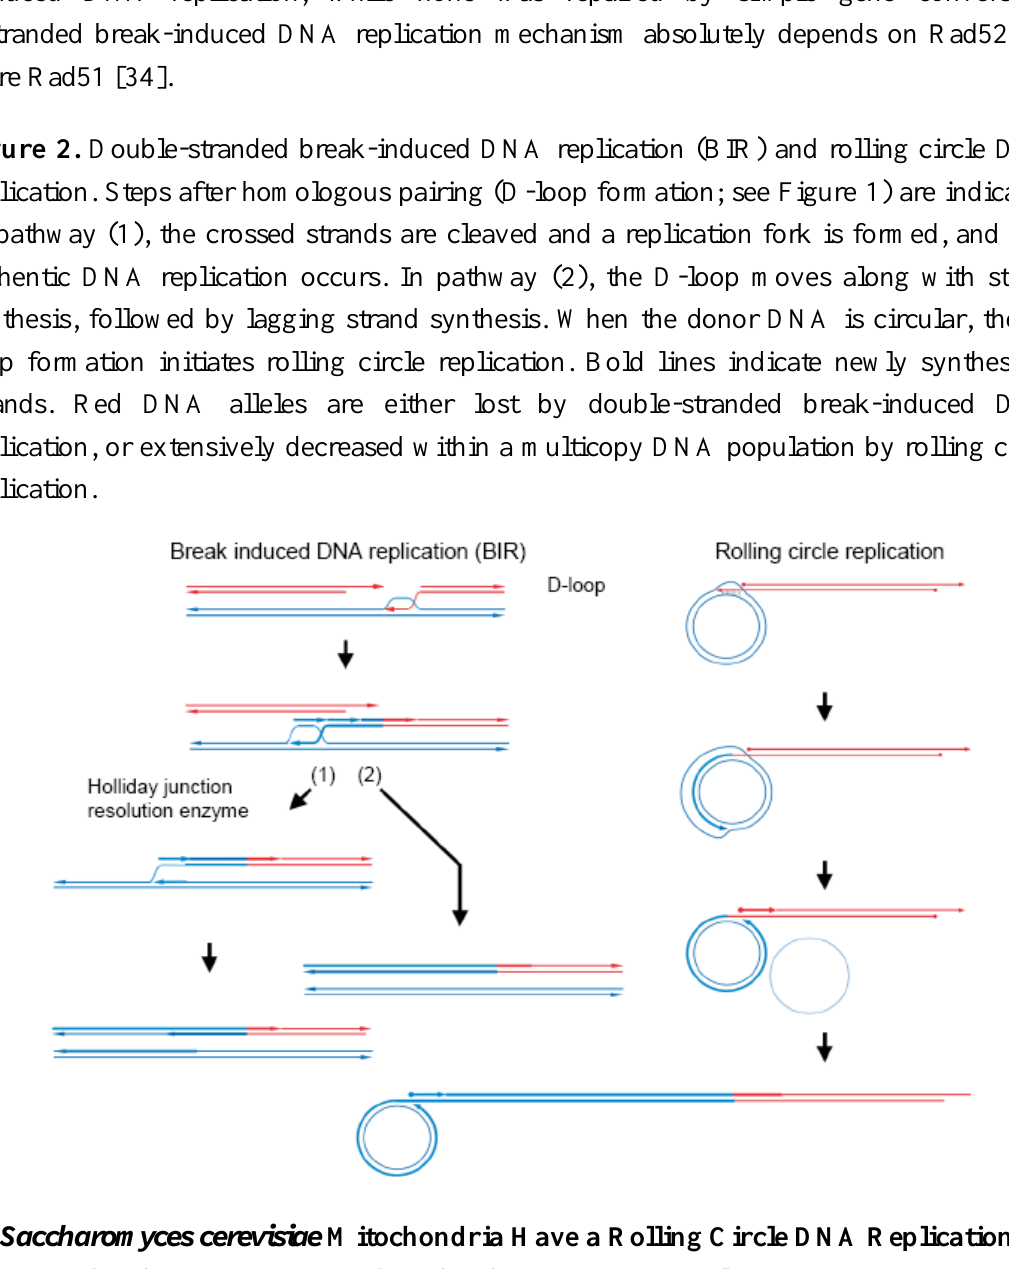
Figure 2. Double-stranded break-induced DNA replication (BIR) and rolling circle DNA replication. Steps after homologous pairing (D-loop formation; see Figure 1) are